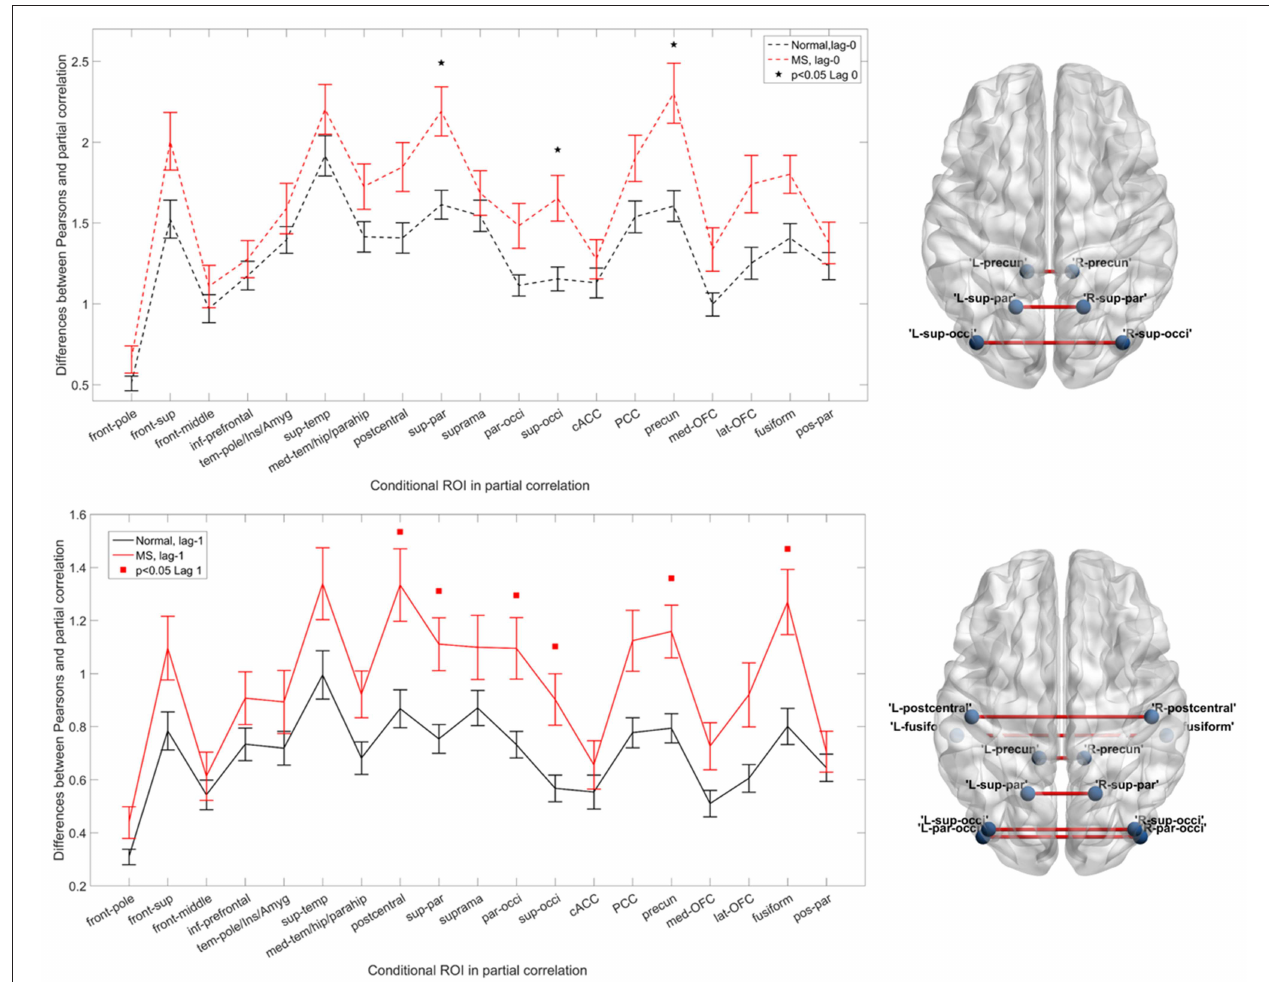
FIGURE 1 | Functional interhemispheric connectivity in healthy controls (HCs) and multiple sclerosis (MS). Upper left panel and lower left panel represent instantaneous and delayed interhemispheric connectivity in MS (red) and HC (black), respectively. The differences between Pearson’s correlation and partial correlation represent the relative importance (connectivity values) of the brain regions of interest [conditional region of interest (ROI)] when it is included or excluded from the analysis. A larger difference reflects greater importance of that region. Black stars and red squares indicate the connection pairs, which significantly distinguish the two groups in instantaneous and delayed connectivity [ p < 0.05, false discovery rate (FDR) corrected], respectively. Upper right and lower right panels show the altered connections on a brain template. The visualization was done in the BrainNet Viewer ( 50). Abbreviations are shown in Table 2